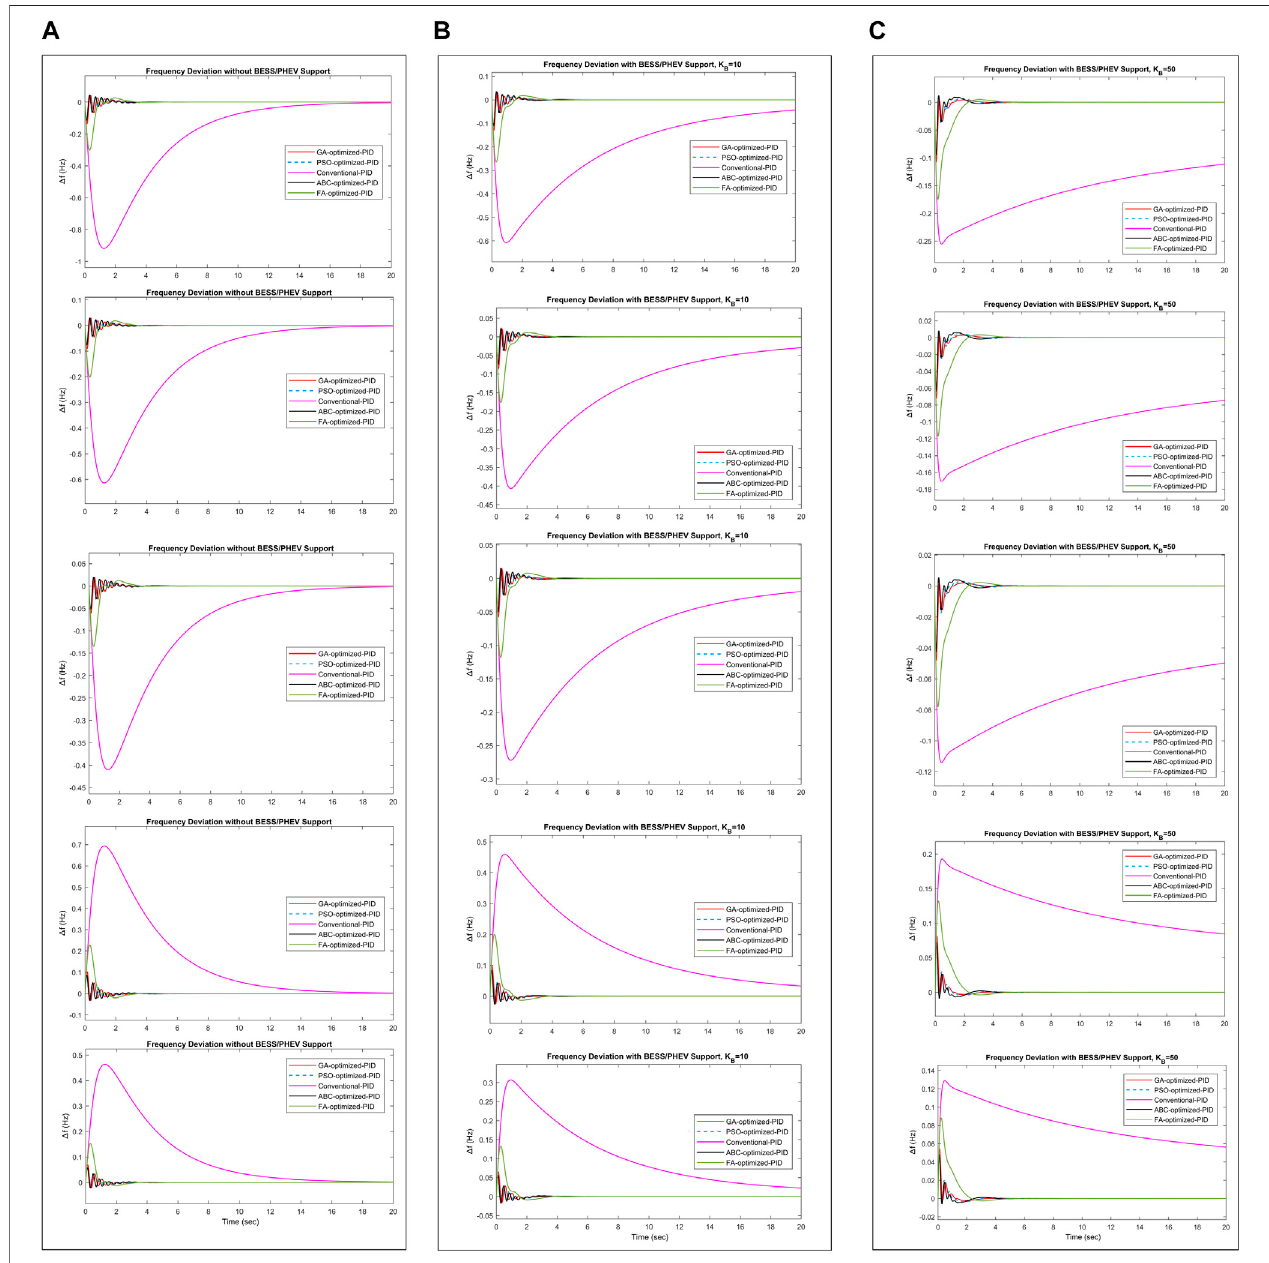
FIGURE 7 | Frequency deviation response using integral time absolute error (A) without BESS/PHEV support (B) with BESS/PHEV support, K B (cid:2) 10 (C) with BESS/PHEV support, K B (cid:2)